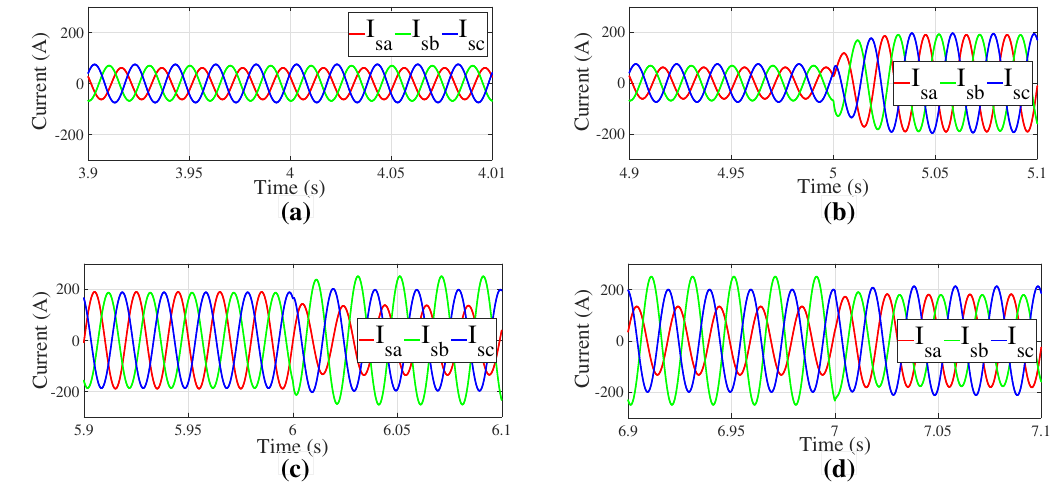
Figure 5. Evolution of the stator currents (A) when changing from: ( a ) regular control